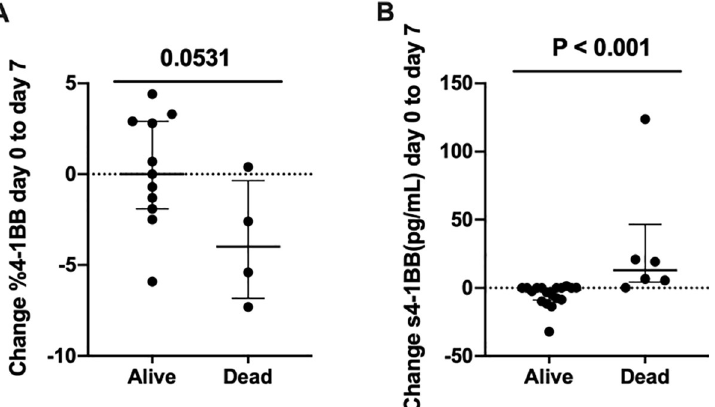
Fig 4. Early changes in 4-1BB is associated with mortality. Change in frequencies of 4-1BB + CD4 + T lymphocytes measured using flow cytometry (A) and plasma s4-1BB measured with enzyme-linked immunosorbent assay (B) from day 0 to day 7 in patients with alcoholic hepatitis. Patients dead by day 90 compared with those still alive. Flow cytometry data compared using T test and ELISA data compared using Mann-Whitney rank sum test. Graphs shown as median ± interquartile